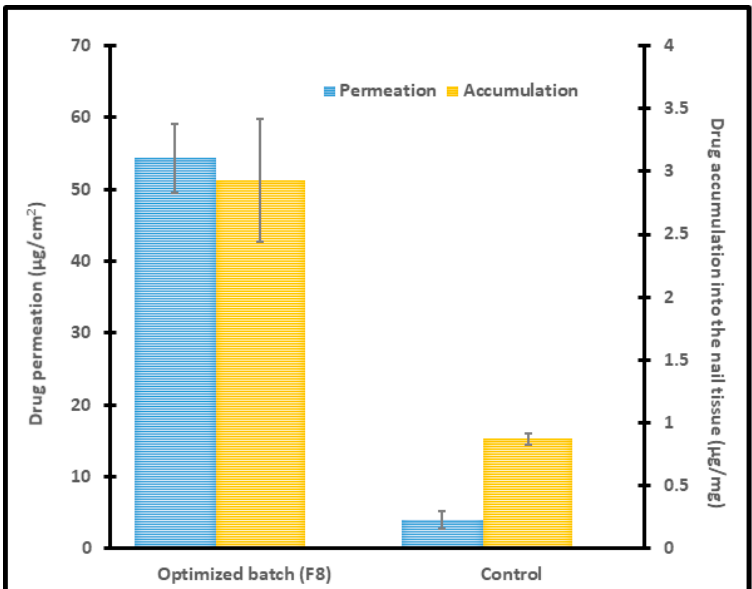
Figure 7. Permeation and drug accumulation into the nail tissue by optimized batch (F8) using iontophoresis (12 V for 6 h) and control (0 V for 6 h). The data represents mean ± SD ( n = 6).